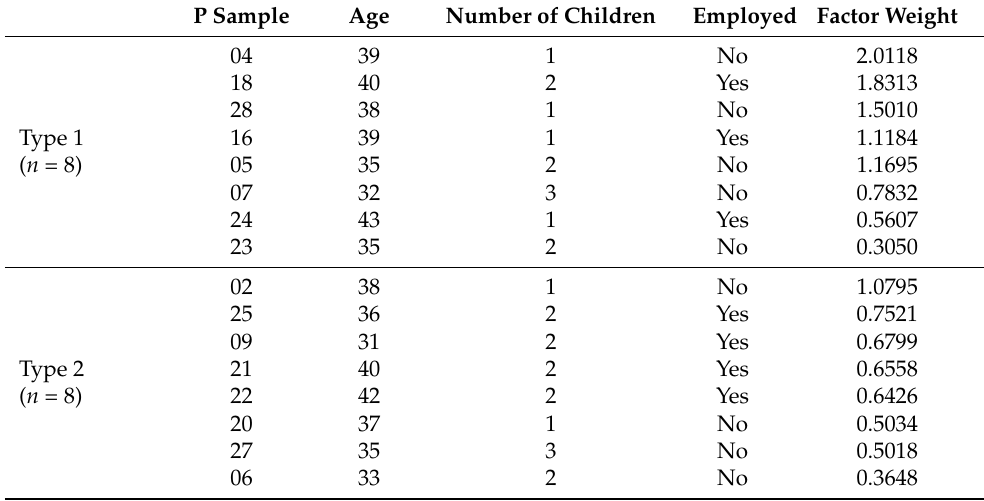
Table 2. Sociodemographic characteristics and factor weights by